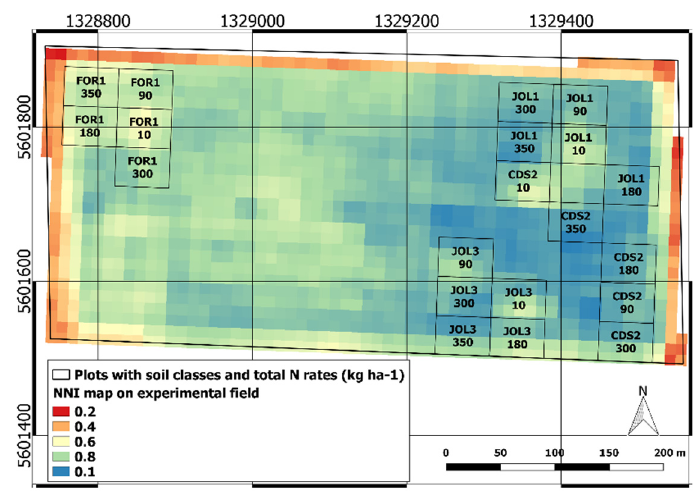
Figure 9. NNI map derived on the experimental field with the direct method from the NDRE of the S2 image of 08-July. Rectangles show the locations of the plots, the corresponding soil classes (see Figure 1), and total N rates provided during the season (kg N ha − 1 ). Table 9. Yield and NNI mean values (directly derived using S2 image of 08 July) of each maize field of the farm analyzed using the ANOVA method (different letters are significantly different at p < 0.05).